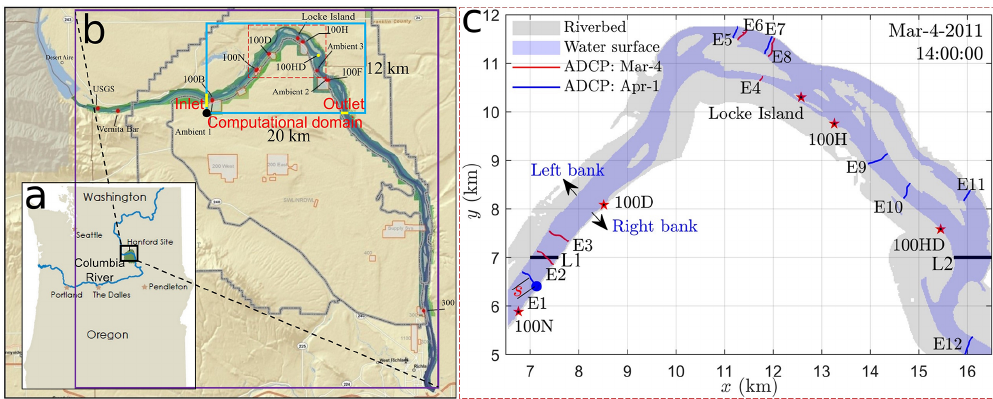
Figure 1. The location of the study site within Washington State and the Columbia River (a) , the computational domain with the river bathymetry and water-stage survey locations (b) , and the exact locations of velocity and stage measurements (c) . Yellow lines in panel (b) represent the inlet and outlet locations of the computational domain. Red and yellow dots in panel (b) denote water-stage survey locations. Red and blues lines in (c) denote boat paths measured on two dates. Red stars and horizontal black lines in panel (c) represent the zoom- in of the stage survey locations in (b) and the locations (L1 and L2) selected to evaluate the sensitivity of stage and velocity variations to roughness heights, respectively. Panel (a) is a reused image of the Oregon Department of Energy (https://www.oregon.gov/energy, last access: 30 January 2022); panel (b) is modified from Fig. 1 in Niehus et al. (2014) produced by Sara Kallio at Pacific Northwest National Laboratory